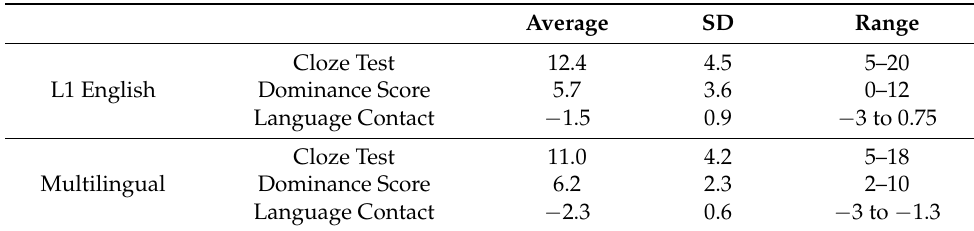
Table 2. Learner cloze test, language dominance, and language contact scores for PT.